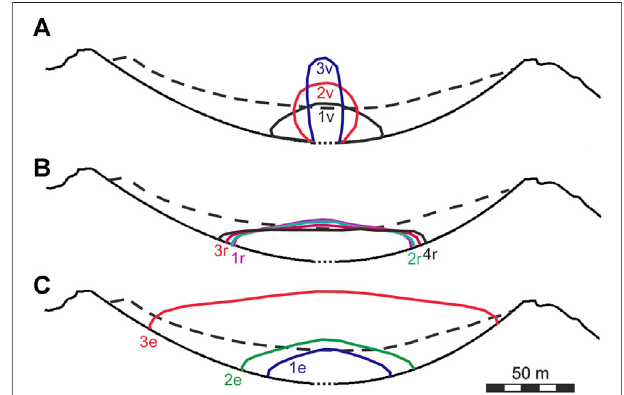
FIGURE 4 | Lava dome growth in experiments 1-3. The dashed line presents thecrater ’ srim. (A) Blackcurve1v (exp.1.1),red curve2v (exp.1.2), and blue curve 3v (exp. 1.3) present the morphological shape at the time t (cid:1) 70daysforthecrystal-freemagmaviscosity η p (cid:1) 1 . 6 × 10 5 ,8 × 10 5 ,and 8 × 10 6 Pa s, respectively. (B) Purple curve 1r (exp. 2.1), green curve 2r (exp. 2.2), red curve 3r (exp. 2.3), and black curve 4r (exp. 2.4) present the morphological shape at the time t (cid:1) 150 days for CCGT of 5, 15, 50, and 100 days, respectively. (C) Blue curve 1e (exp. 3.1), green curve 2e (exp. 3.2), and red curve 3e (exp. 3.3) present the morphological shape at the time t (cid:1) 150 days for the extrusion rate 5 × 10 − 6 , 10 − 5 , and 5 × 10 − 5 m s − 1 , respectively.